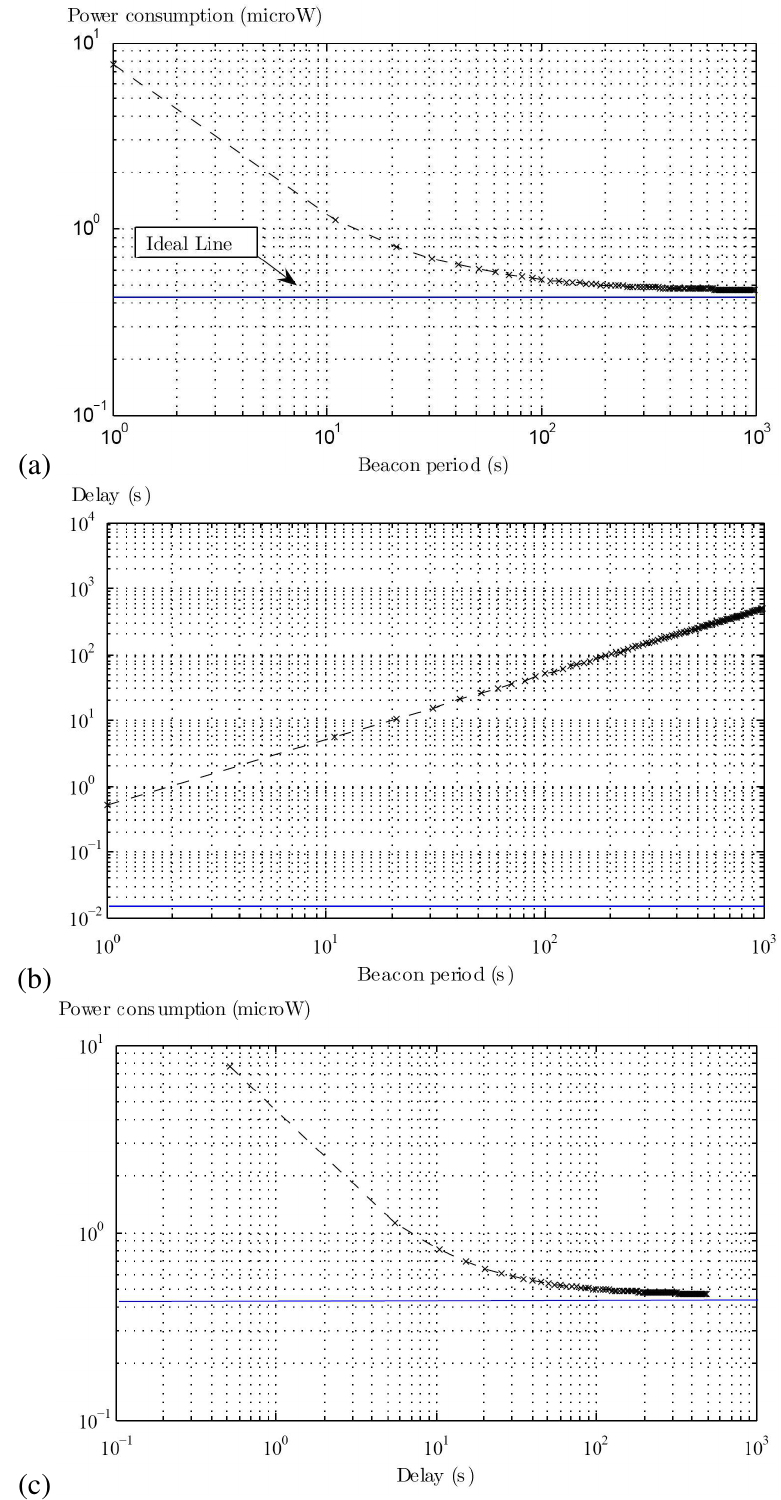
Figure 8. (a) Power consumption vs. Beacon period (b) Delay vs. Beacon period (c) Power consumption vs.